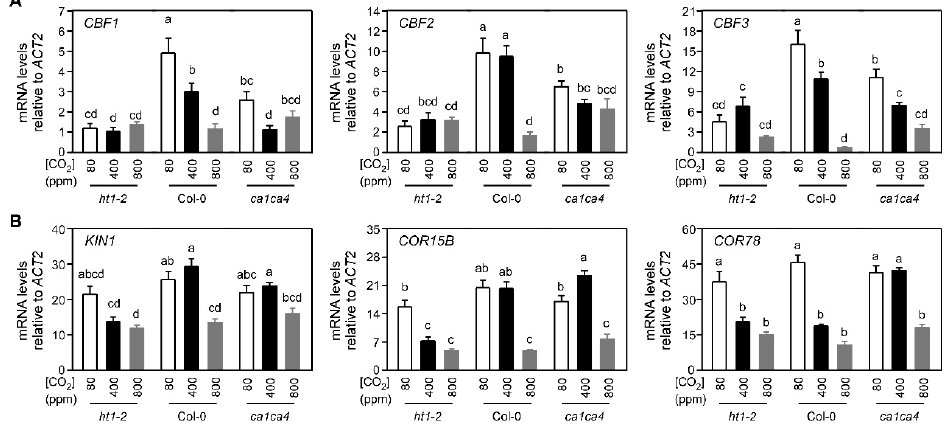
Figure 3. The low temperature expression of CBFs ( A ) and downstream CBF-dependent genes ( B ) under varying CO 2 levels (800, 400, and 80 μ mol mol − 1 ) was altered in two Arabidopsis CO 2 stomatal response mutants along with wildtype control, Col-0. Transcript abundance was determined using Arabidopsis (Col-0) plants and two stomatal response mutants that were hypersensitive or insensitive to CO 2 (i.e., ht1-2 and ca1ca4 , respectively). Individual 3.5-week-old plants grown at 22 °C were exposed to 4 °C temperature for 2 h under ambient CO 2 conditions. Relative values are means (×1000) of three biological replicates and two technical replicates (error bars indicate SEM). Bars labeled with different lowercase letters differed at p ≤ 0.05 and differences were determined using two-way ANOVA and Tukey HSD. This experiment was performed independently from the one in Figure 1; therefore, the data values are not the same, but a similar trend was